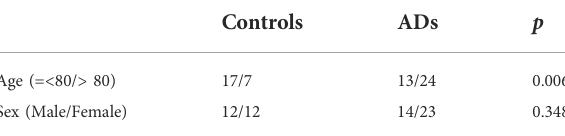
TABLE 1 Characteristics of the entorhinal cortex tissue in AD and control samples in the GSE118553 dataset.